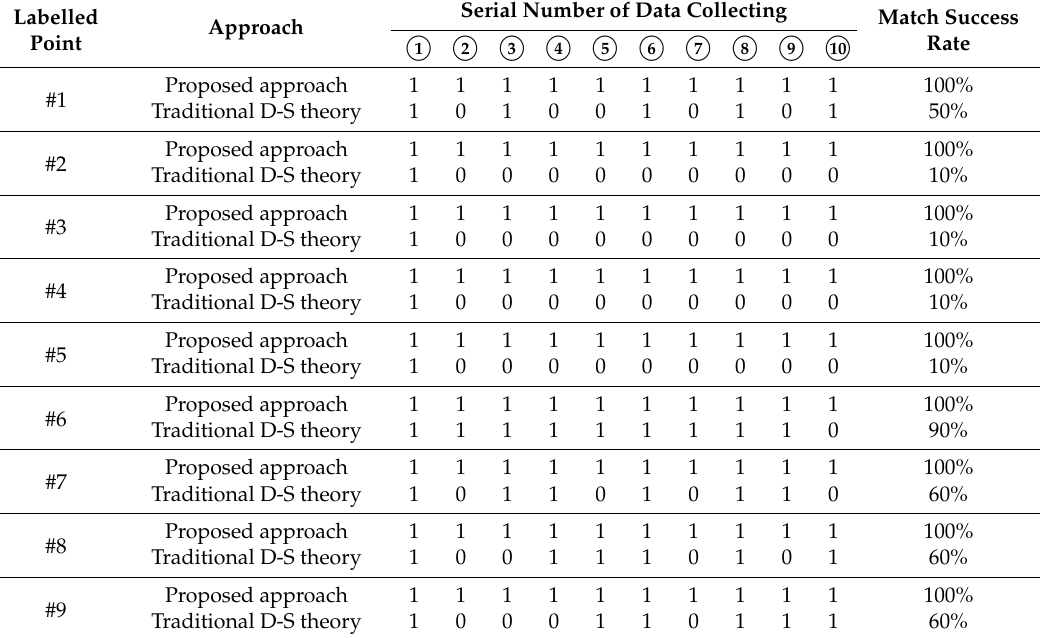
Table 8. Match success rate of the proposed approach and traditional D-S